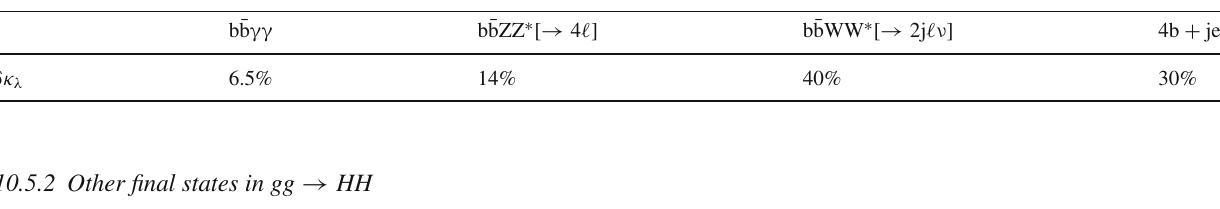
Table 10.2, where the results were obtained with the baseline detector performance parameters, and a 1% systematics on the rates of the signals and of the leading